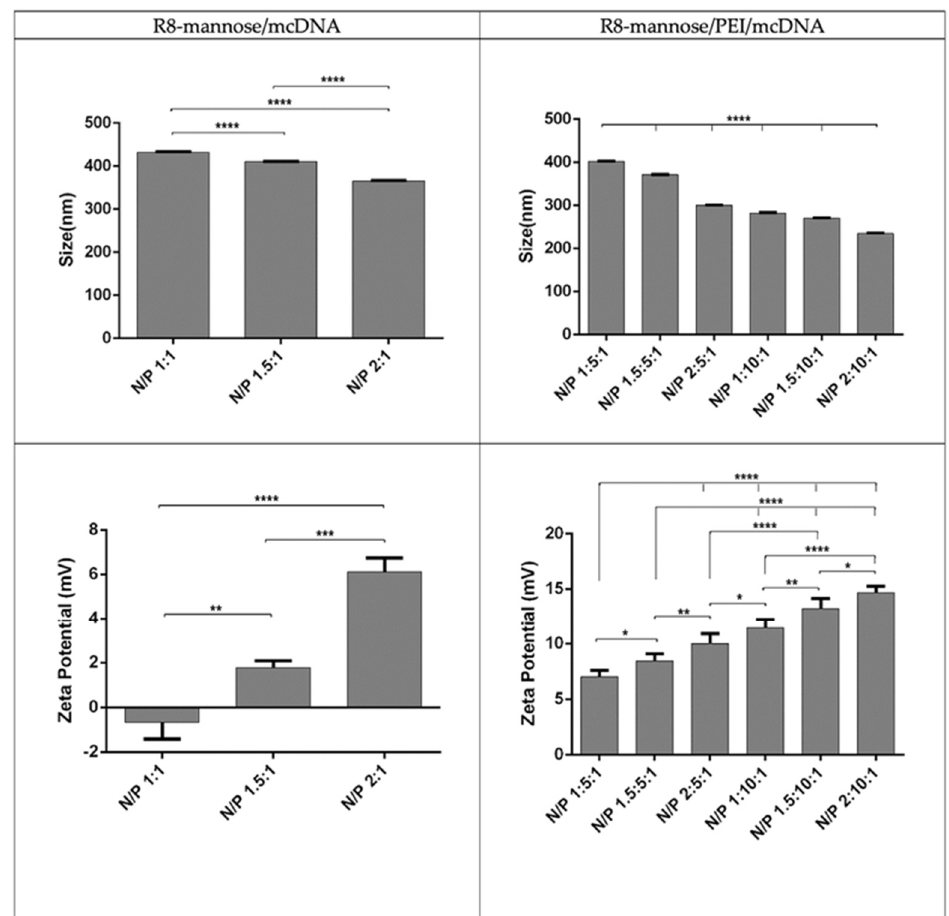
Figure 5. Mean sizes (nm) of binary and ternary systems and average zeta potentials (mV) of binary and ternary systems formulated at different N/P ratios. The values were calculated with the data obtained from three independent measurements (mean ± S.D., n = 3); * p < 0.05; ** p < 0.01; *** p < 0.001; **** p < 0.0001.